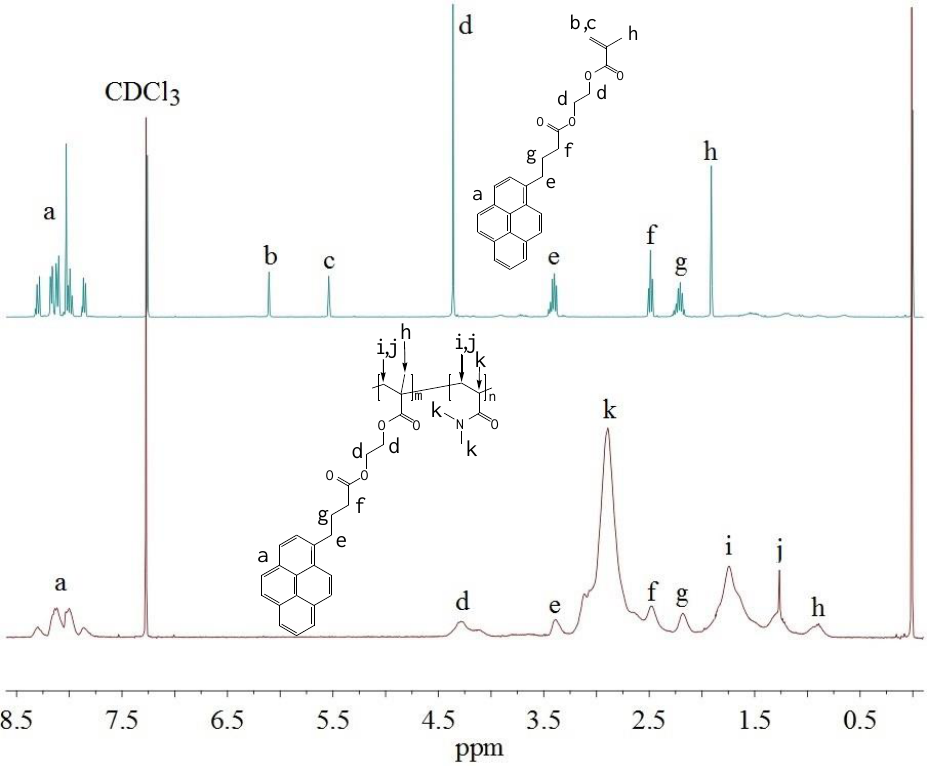
Figure 3. 1 H NMR spectra of PyBEMA monomer and PDMAA-12.7 copolymer in CDCl 3 .